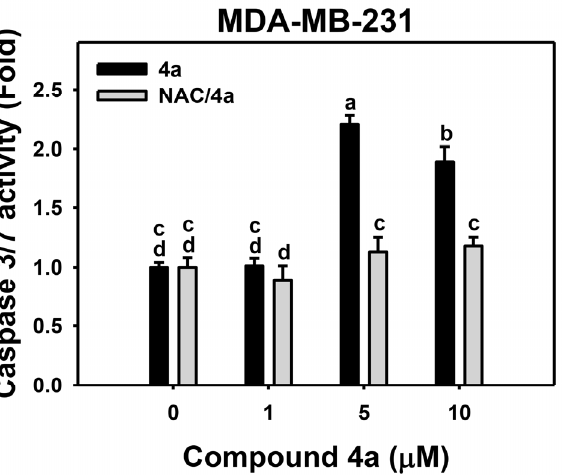
Figure 5. Upregulation of caspase 3/7 activity of breast cancer cells by compound 4a . MDA-MB-231 cells were pretreated with 1 h N -acetylcysteine (NAC) and post-treated with 4a for 24 h. Caspase 3/7 activity was determined by luminescence detection. Data, means ± SDs ( n = 3). Data containing non-overlapping notes exhibited significant differences ( p < 0.05). The letters (a, b, c, d) were provided by the statistical JMP software for determine significance. “a” is the biggest value and others follow the order.